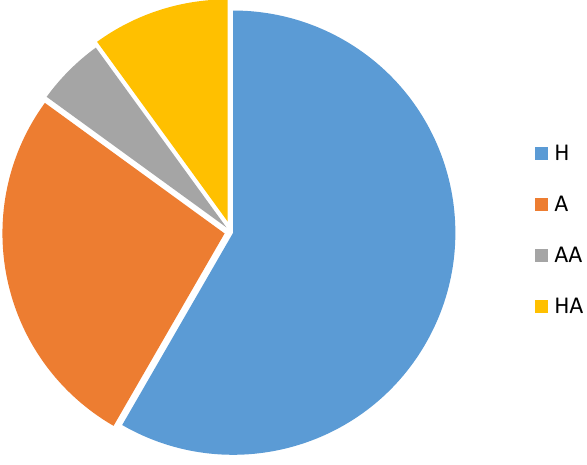
Fig. 12 Chart showing the curve